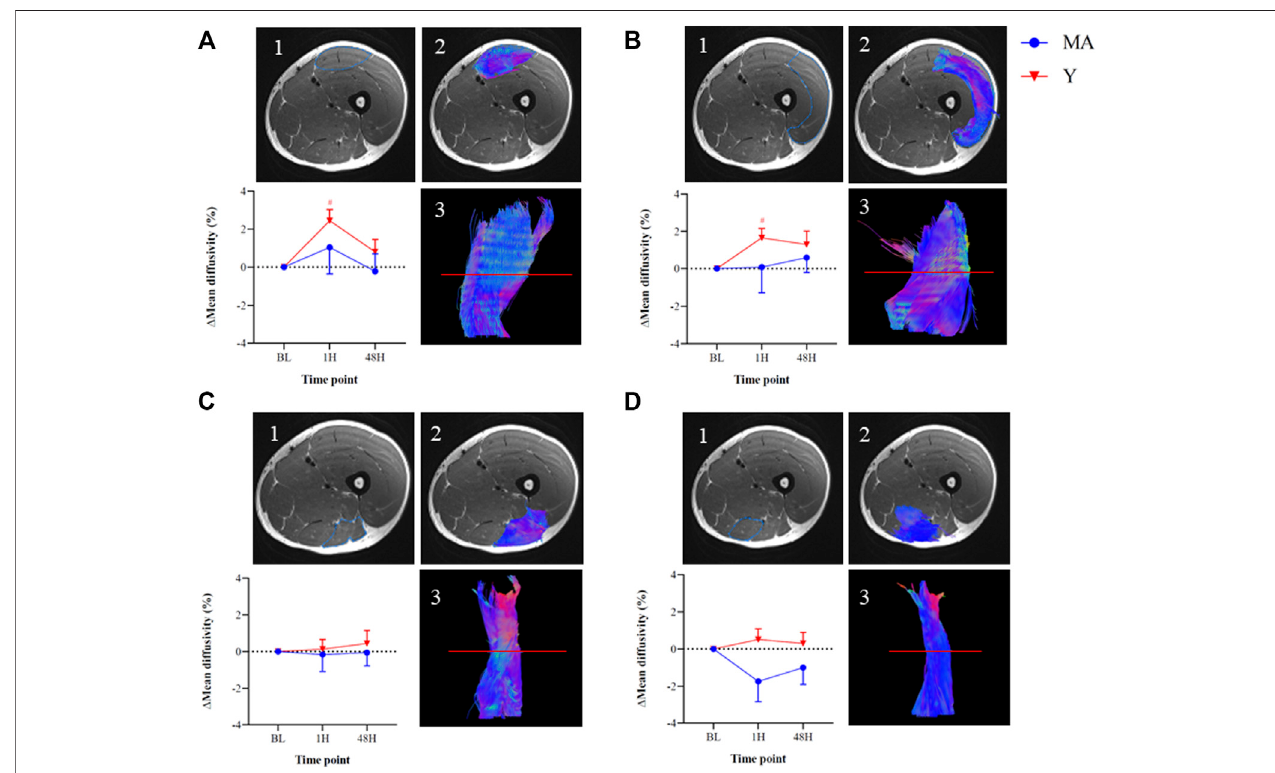
FIGURE 5 | Changes in mean diffusivity within the thigh muscles of the right leg relative to baseline (BL) measured using magnetic resonance imaging diffusion tensor imaging (MRI DTI) imaging: Rectus femoris [panel (A) ], Vastus lateralis [panel (B) ], Biceps femoris [panel (C) ], and Semitendinosus [panel (D) ]. The images represent an MRI-DTI analysis of the thigh muscles of one representative young participant at BL. 1. Region-of-interest on an axial slice 2. Colored region-of-interest on an axial slice 3. Tractography of individual muscle using DTI analysis on sagittal slice, based on the axial slice (red line). The colors within the images represent; Blue — Superior/cranial or Inferior/caudal, Green — Anterior or Posterior, Red — Distal or Proximal. Measurements were taken as BL, 1 h (1H) and 48 h (48H) following a 60 min downhill running protocol. Young (Y; red triangle) and middle-age (MA; blue circles) groups. Dotted horizontal line represents no change compared to BL. # Signi fi cant ( p < 0.05) difference compared with BL within each group. All data are reported as mean ±